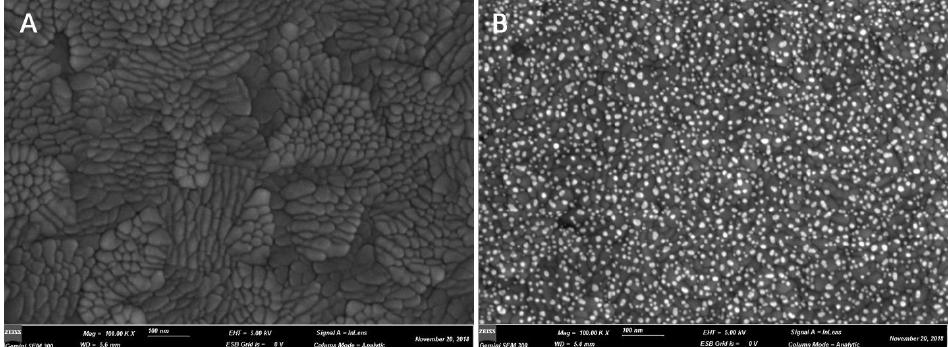
Figure 2. The scanning electron microscope images of the bare ITO electrode ( A ) and the ITO electrode modified with 0.25 mM ( B ) by electroplating.